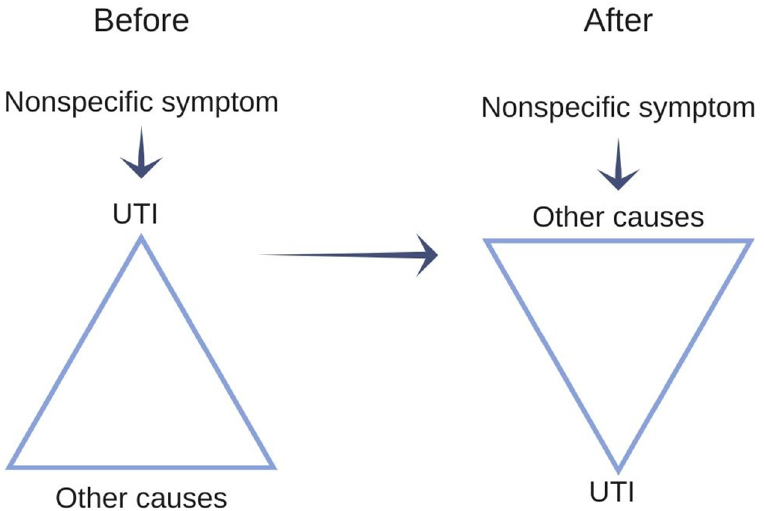
Figure 3. Illustration of the reverse triangle, similar to the one used in the case-based education material.